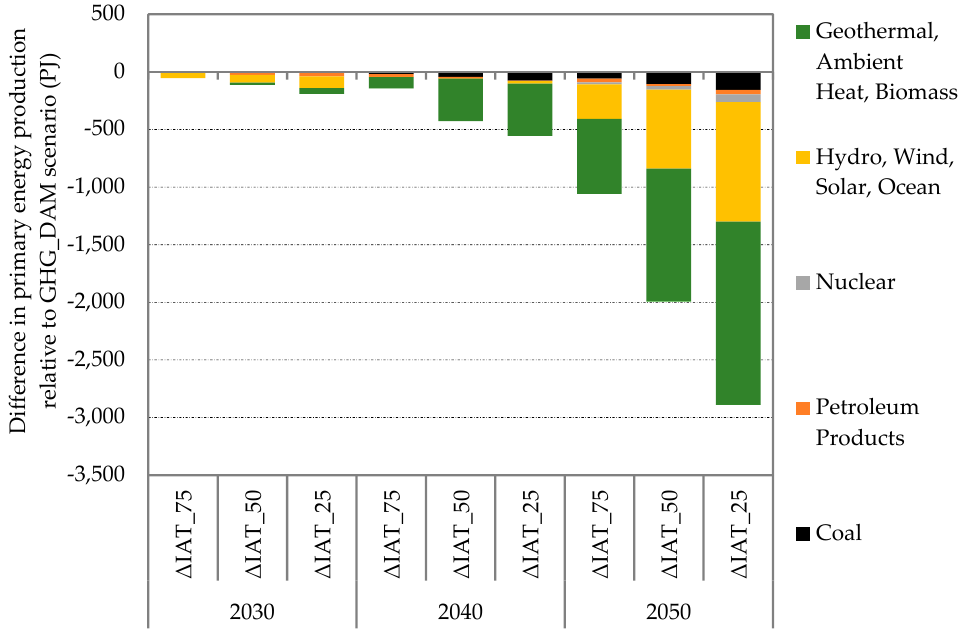
Figure 10. Difference in primary energy production relative to GHG_DAM scenario in the EU28 Figure 10. Di ff erence in primary energy production relative to GHG_DAM scenario in the EU28 (PJ).